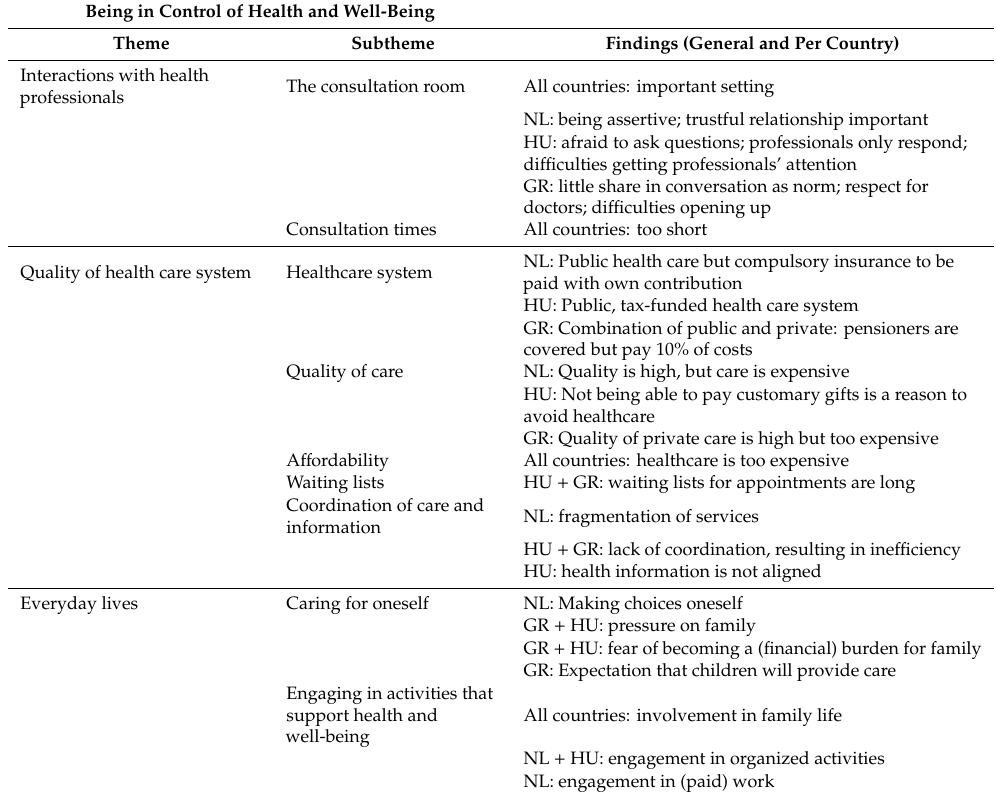
Table 5. Summary of